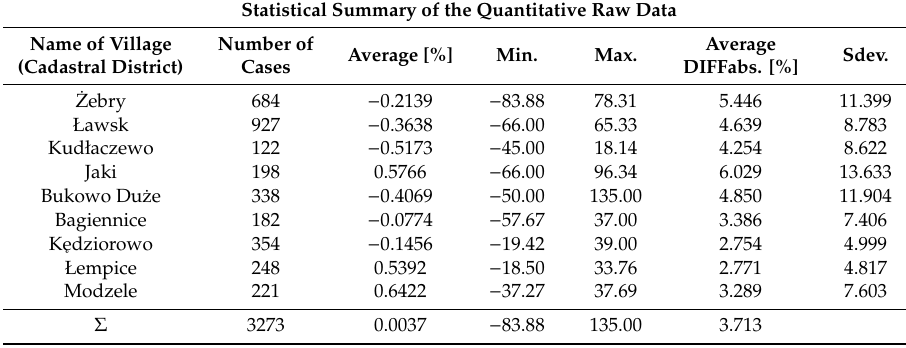
Table 3. Description of nominal